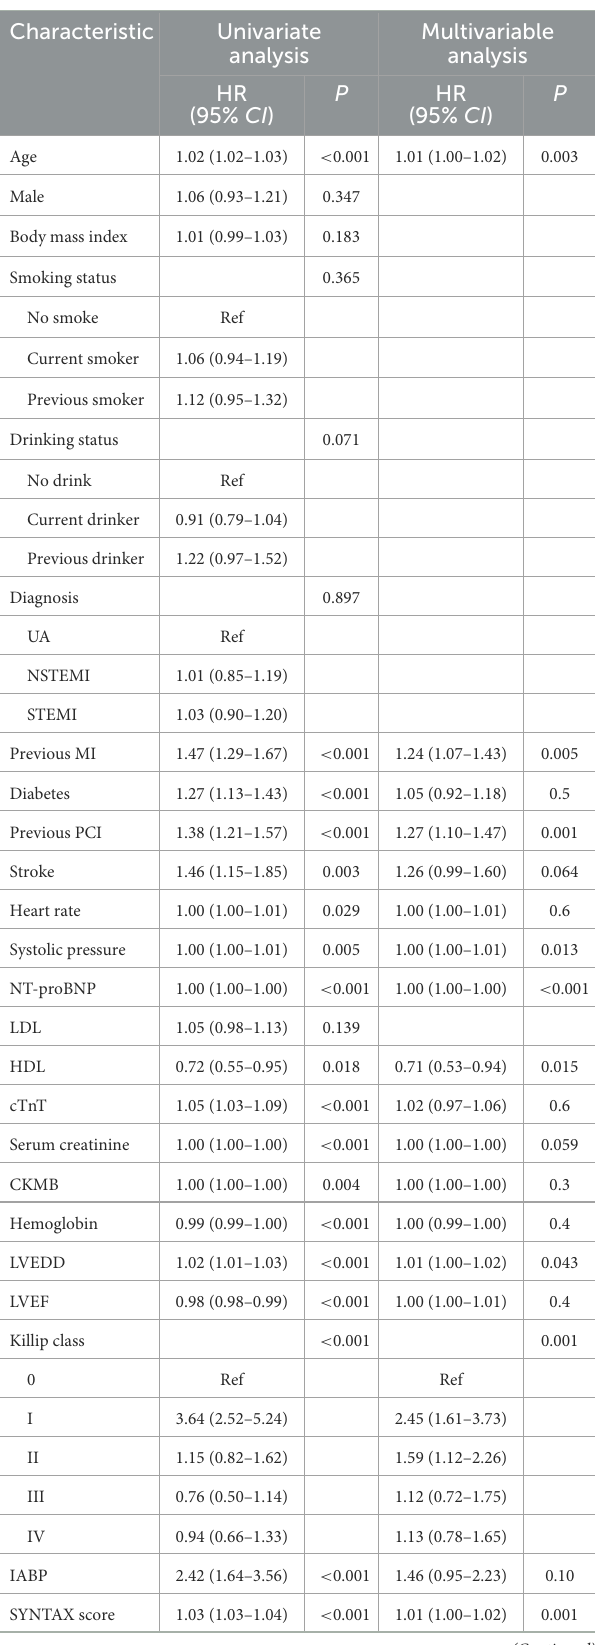
TABLE 2 Univariate and multivariable analysis of MACE in patients with